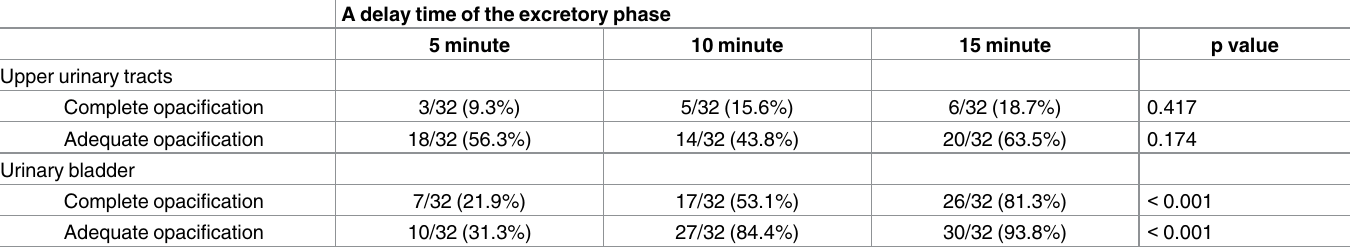
Table 2. Comparison among single-phasic excretoryphase for complete and adequate opacification of the upper urinary tracts and the urinary bladder.